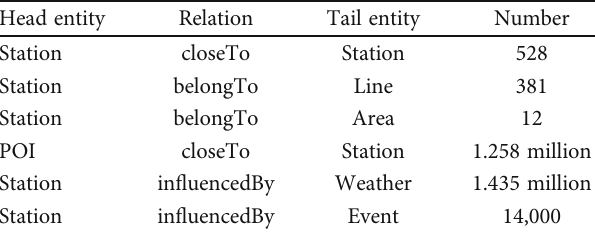
Table 2: Edges of metro knowledge